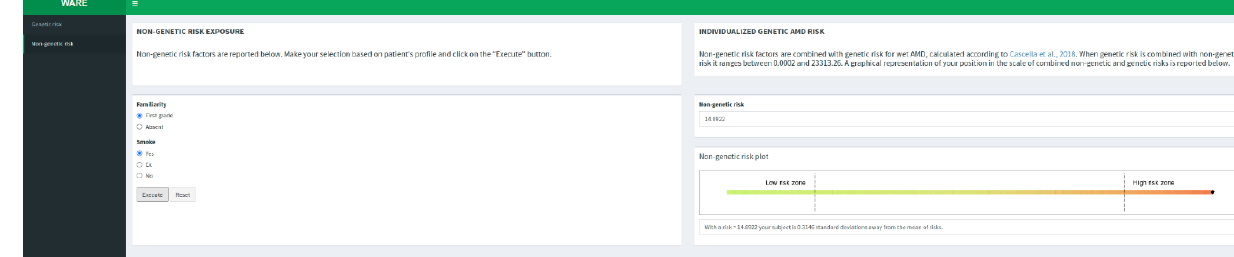
Figure 2. Non-genetic risk tab